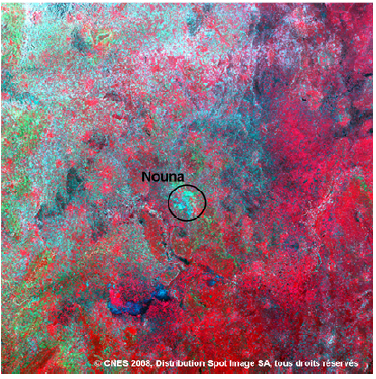
Figure 3 : Image SPOT-5 du 9 septembre